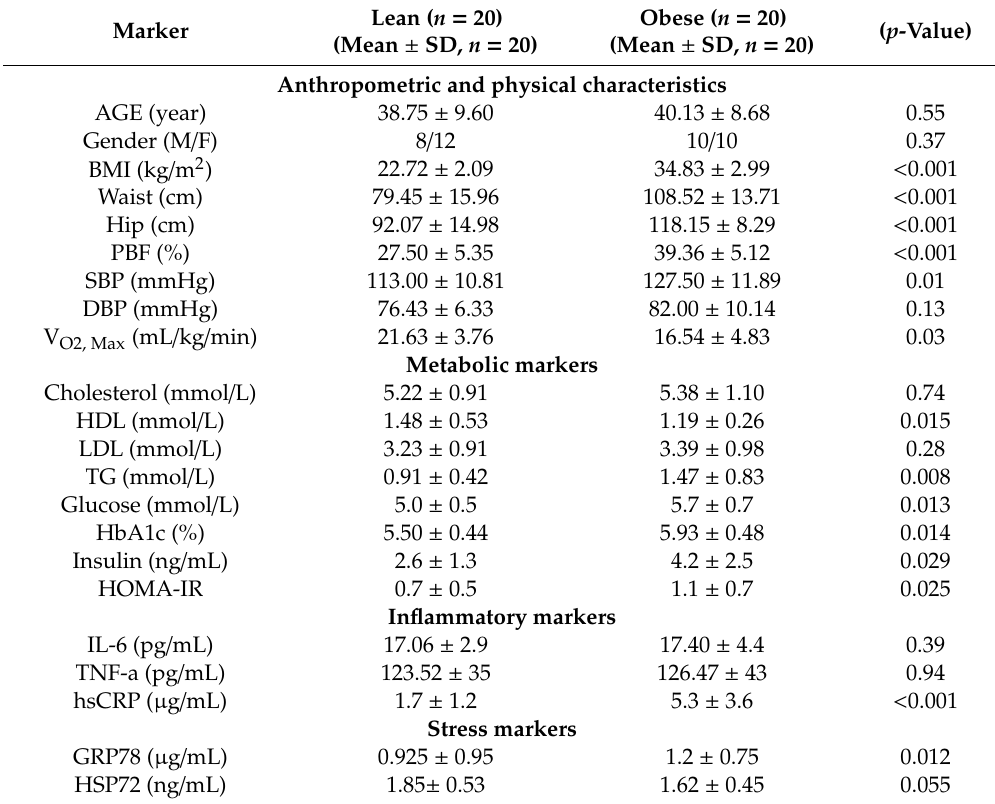
Table 1. Physical, clinical, and biochemical characteristics of the cohort study at baseline.